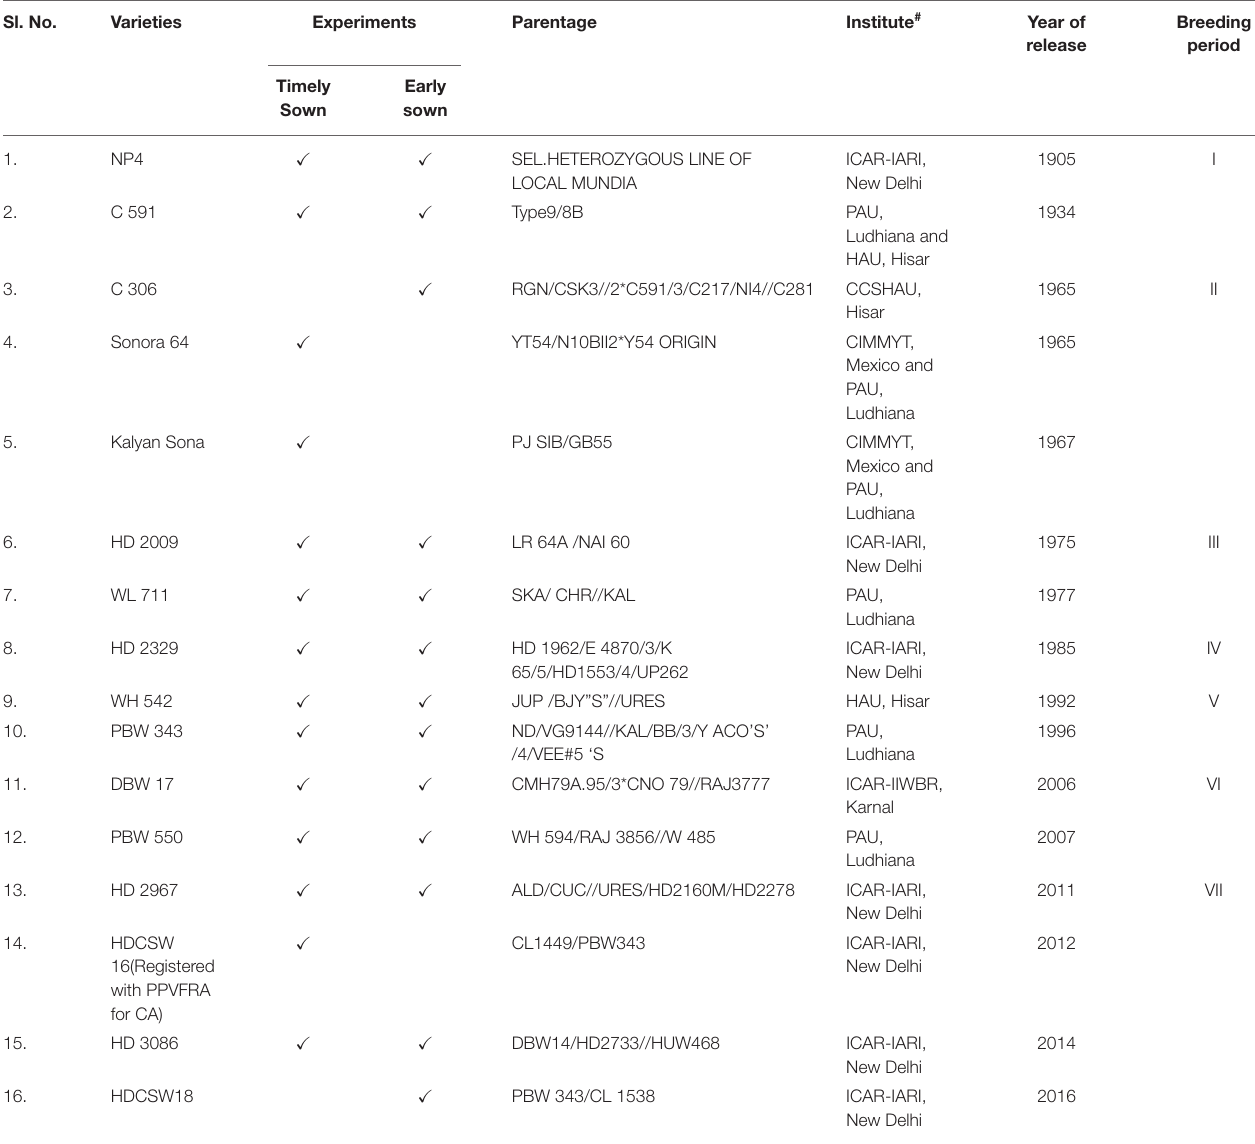
TABLE 1 | List of genotypes, parentage information, developing Institute, and their year of release. Sl.